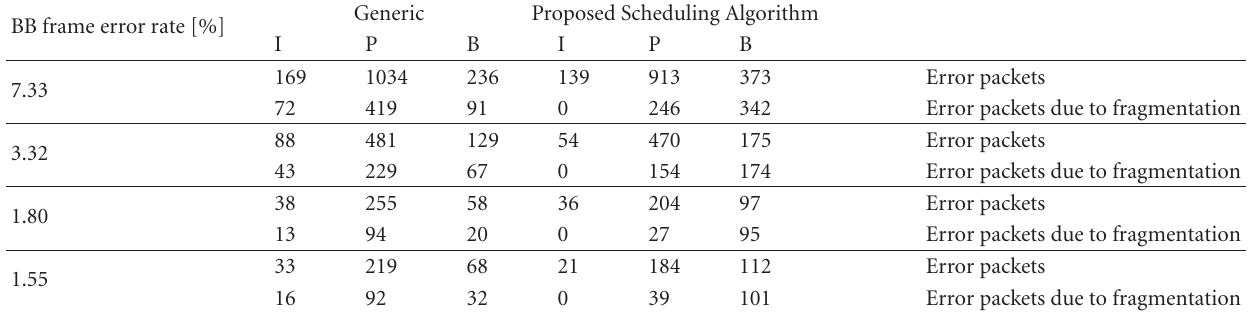
Table 7: Number of erroneous packets